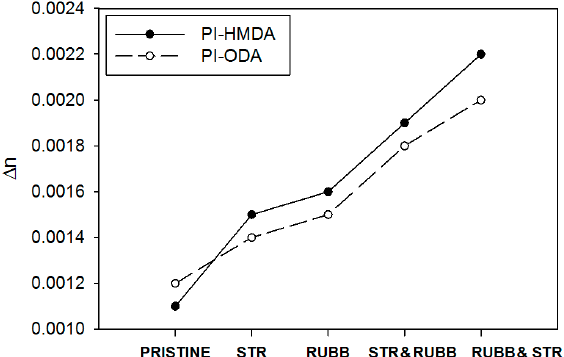
Figure 3. The variation of the birefringence of the pristine and surface adapted PI-HMDA and PI-ODA films.